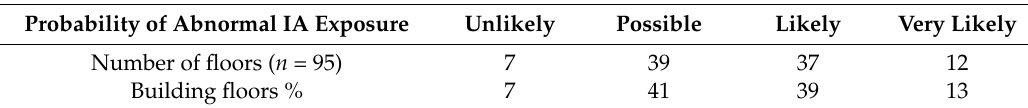
Table 6. The probability of abnormal IA exposure was assessed in 95 building floors. Probability of abnormal AI exposure categories is based on the method described in Sections 2.2 and